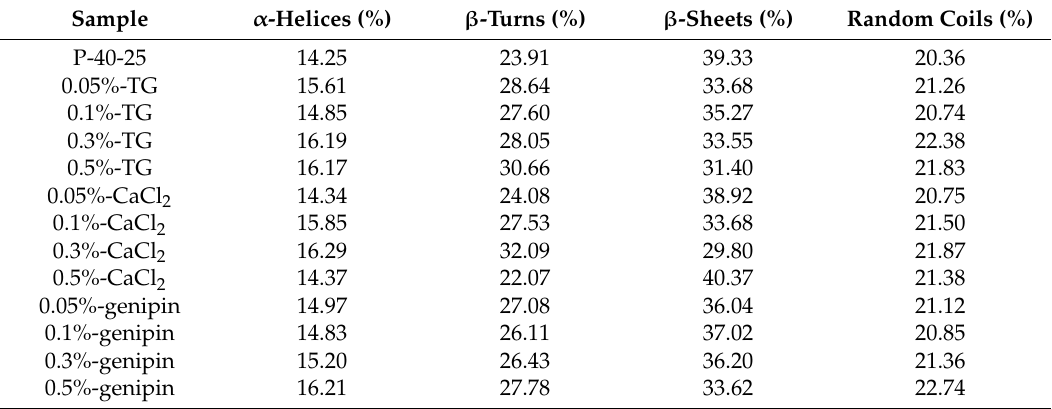
Table 2. Effect of the cross-linking agent contents on the FK secondary structure. Sample α -Helices